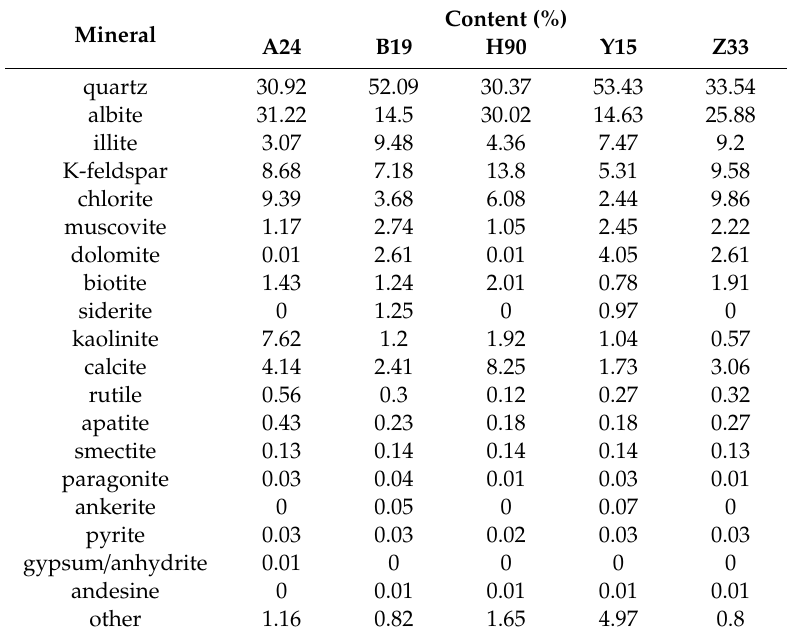
Table 2. Mineral content obtained from QUEMSCAN